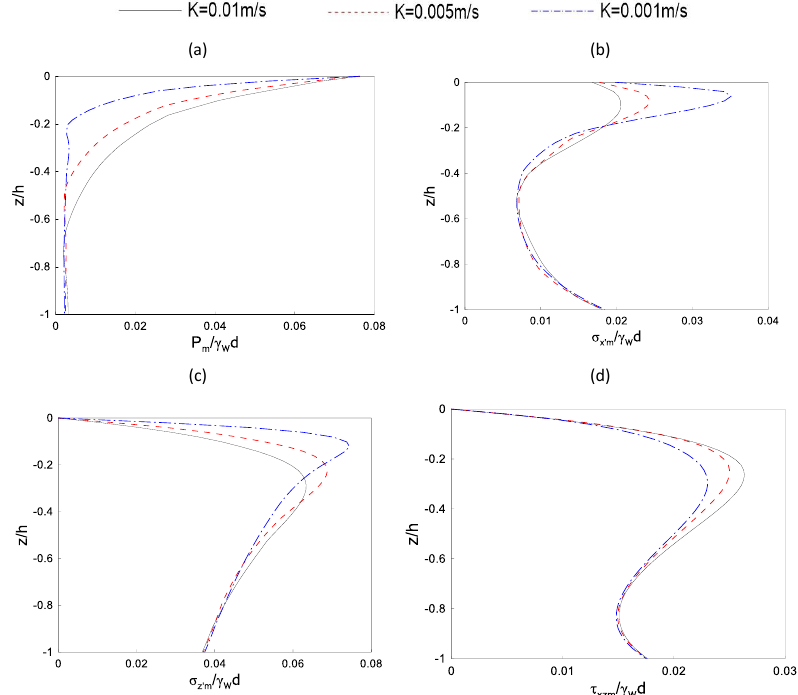
Figure 23. Distribution of the maximum soil response under the random wave with various soil per- meabilities. ( a ) pore-water pressures ( p m / γ w d ); ( b ) horizontal effective normal stress ( σ (cid:48) xm / γ w d ); ( c ) vertical effective normal stress ( σ (cid:48) zm / γ w d ); and ( d ) shear stress ( τ xzm / γ w d